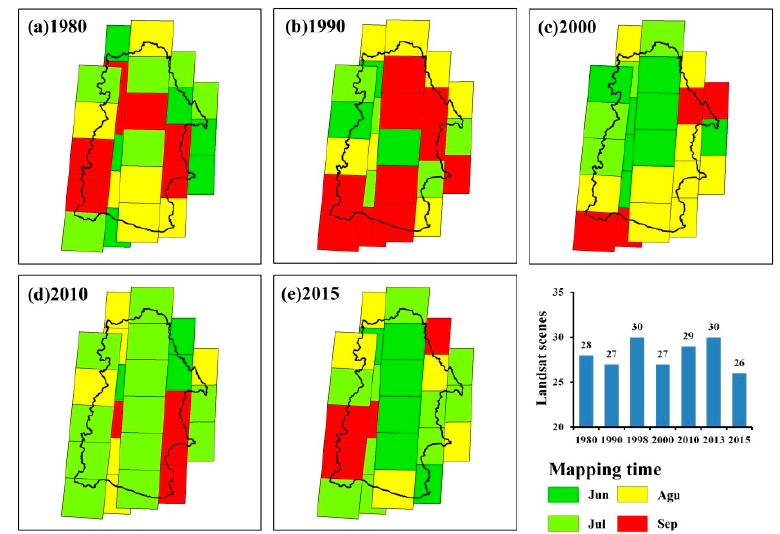
Figure 2. Landsat images selection in optimum months for different dates.